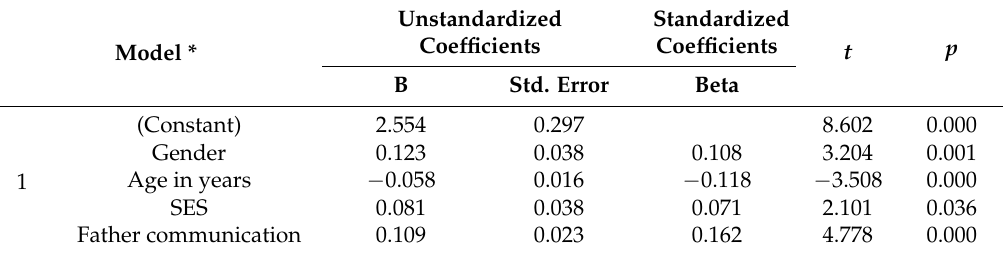
Table 3. Regression analysis coefficients with PA as a dependent variable.